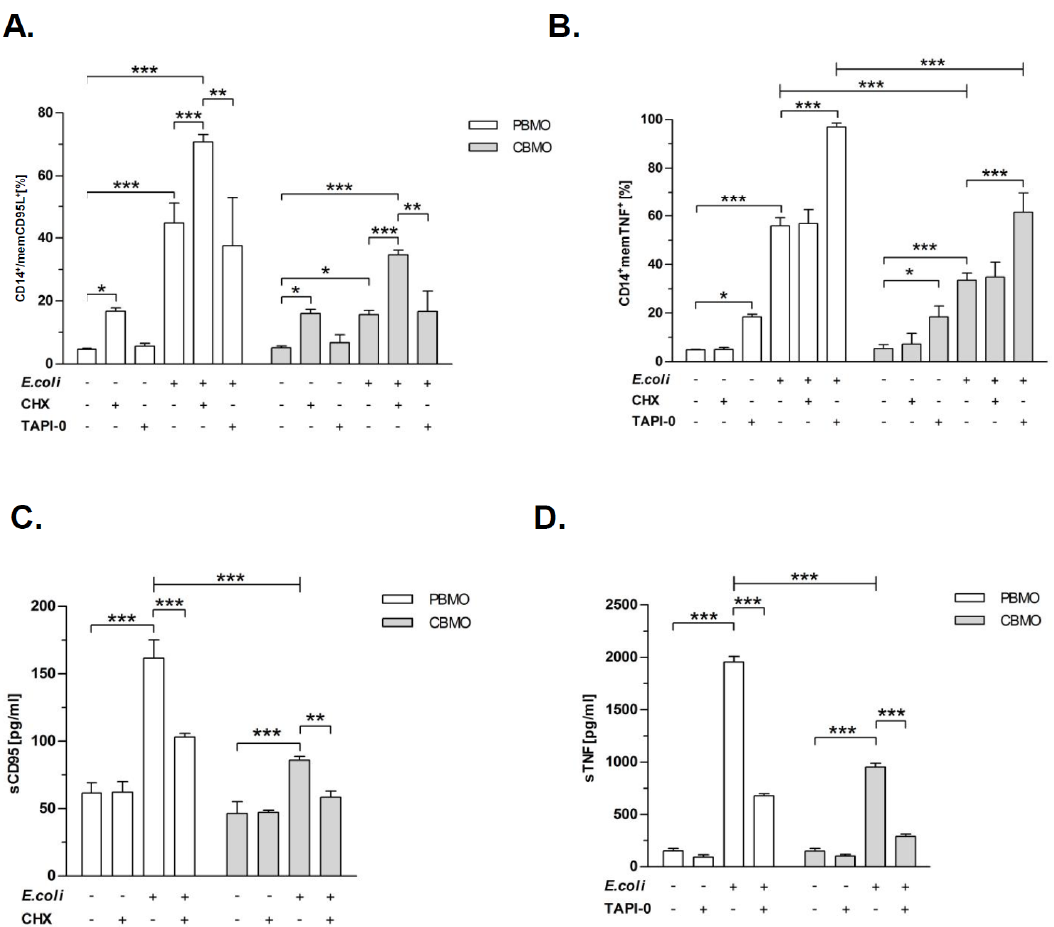
Figure 2. Blockage of metalloproteinases modulated expression of memCD95L and memTNF. PBMO and CBMO were infected and/or treated with the indicated metalloproteinase inhibitors. Expression of memCD95L ( A ) and memTNF ( B ) were assessed on CD14-positive gated monocytes. The same groups were analyzed for secreted (s) CD95 ( C ) and TNF ( D ) 24 h p.i. via ELISA ( n = 5, * p < 0.05, ** p < 0.01, *** p < 0.001, forked bars represent Student’s t -test, blunt-ended bars represent